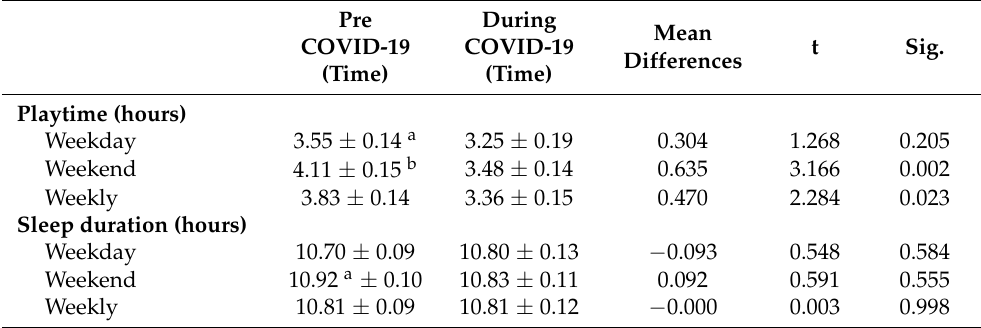
Table 2. Playtime and sleep duration of preschool children before and during the COVID-19